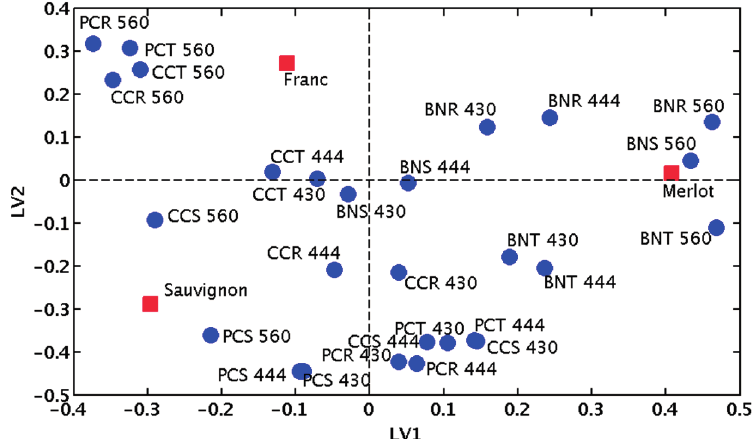
Figure 3. PLSR analysis showing the responses of individual receptors in mono